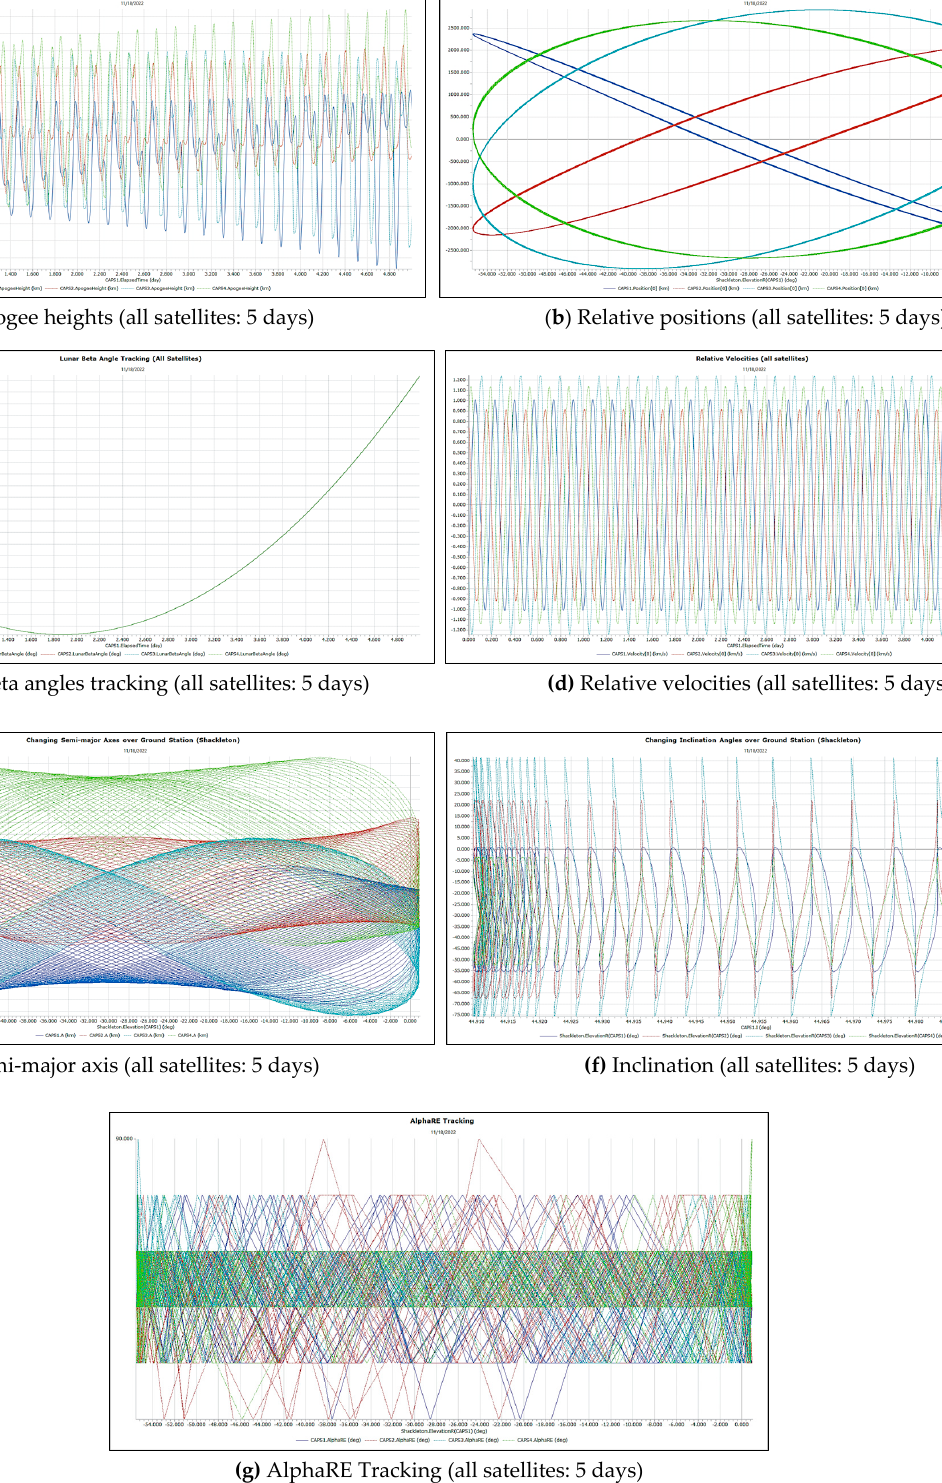
Figure 22. Orientation analysis of the satellites constellating the moon.